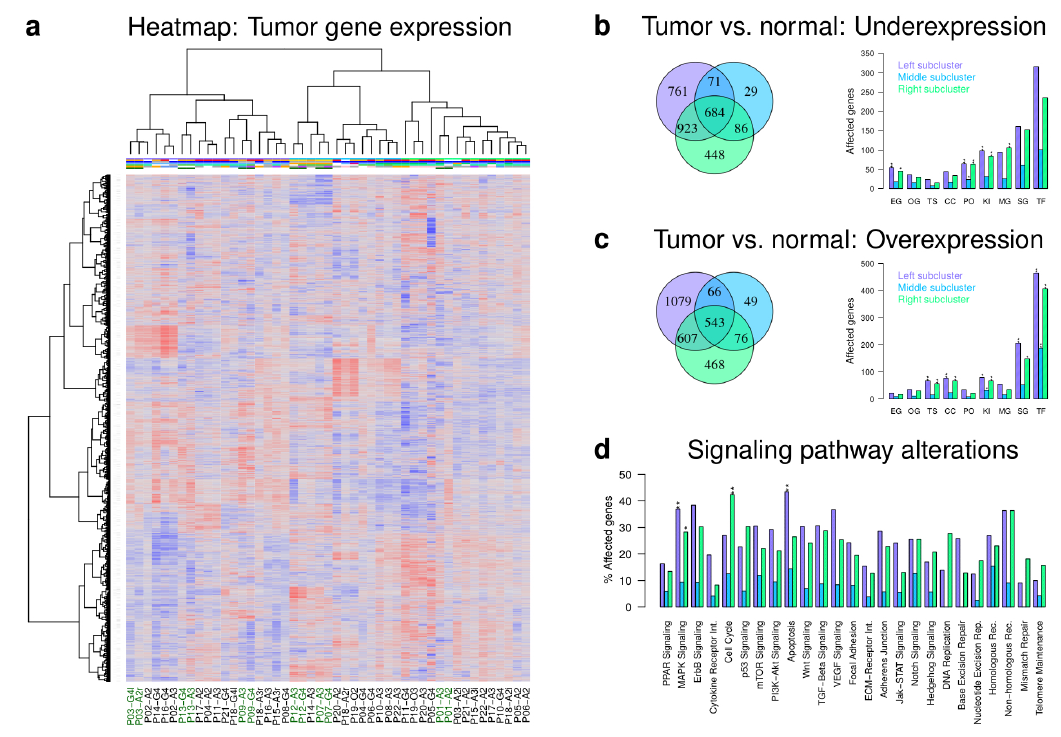
Figure 3. Genome-wide gene expression profiles of individual astrocytomas. ( a ) heatmap of individual tumor gene expression profiles. Tumors were clustered based on the similarity of their gene expression profiles (columns) and their corresponding gene-specific expression values are visualized (rows). The heatmap represents z-score scaled expression levels of each gene with values clearly less than zero in blue shades, values about zero in grey, and values clearly greater than zero in red shades. Three major tumor-specific gene expression clusters are labeled in the first colored line below the dendrogram at the top of the heatmap (left subgroup: lilac, middle subgroup: light blue, right subgroup: green), previous assignments of tumors to the three major aCGH clusters in Figure 2 are shown in the second line, the third line represents the IDH1 mutation status (mutated: blue, wt: grey), the fourth line represents the classification of the tumors according to the Verhaak classes (blue: mesenchymal, orange: classical, green: proneural, white: unclassifiable), the fifth line represents the estimated tumor content of the sample (grey: less than 25%, green: 25–75%, light green: more than 75%, white: not available), the sixth line contains information about treatment before surgery (grey: no, pink: surgery, orange: surgery and irradiation, lilac: surgery, irradiation and temozolomide, blue: surgery, irradiation and non-temozolomide chemotherapy, white: not available), and patient-specific initial and recurrent tumors that directly clustered together are labeled in green in the seventh line. Light and dark grey lines right to the left dendrogram of the heatmap highlight known signaling pathway and cancer genes. Tumor identifiers are shown below the heatmap encoding the patient identifier (Px: x specifies the patient) followed by the tumor type (A2: astrocytoma WHO grade II, A3: astrocytoma WHO grade III, G4: glioblastoma WHO grade IV, O2: oligoastrocytoma WHO grade II, O3: oligoastrocytoma WHO grade III; additional extensions of ‘i’ (initial), ‘r’ (recurrent), and ‘l’ (last recurrent) are added when a patient had more than two tumors); ( b , c ) comparison of differentially expressed genes distinguishing the three major gene expression clusters. Tumors of each major cluster were compared to four normal brain reference samples. The Venn diagram (left) shows similarities and differences between differentially expressed genes at the FDR-level of 1% and the barplot (right) shows corresponding numbers of genes that are part of specific cancer-relevant gene annotation groups (EG: essential gene, OG: oncogene, TS: tumor suppressor gene, CC: cancer census gene, PO: phosphatase, KI: kinase,